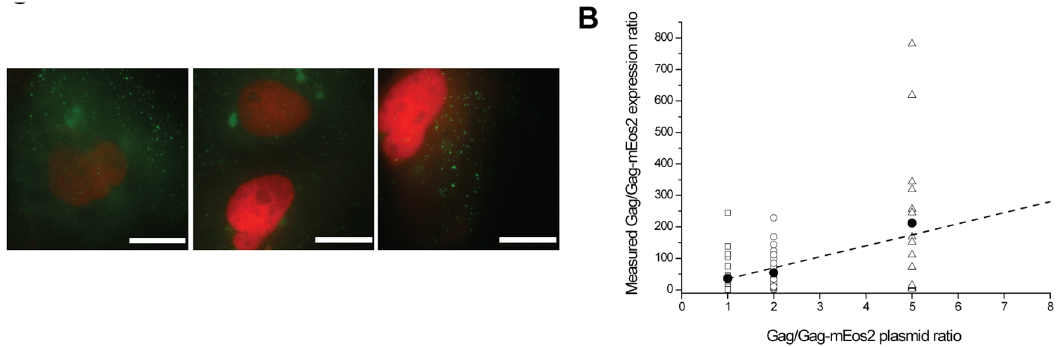
Figure 4. Variability of protein co-expression ratios at the single cell level for identical co-transfection conditions. ( A ) Wide-field images of cells co- transfected with a mixture of pH2B-mPlum/Gag and pGag-mEos2 at an equimolar ratio show high variability in H2B-mPlum expression. ( B ) Measured Gag/ Gag-mEos2 co-expression ratios as a function of the co-transfection ratio of plasmids. Each symbol corresponds to the co-expression ratio measured in a single cell. The black circles show the mean values. The linear fit of the mean co-expression level is plotted as a dashed line. The expression levels were extracted from the extrapolated FCS calibration curves shown in Fig. 3. Scale bars correspond to 5 m m.